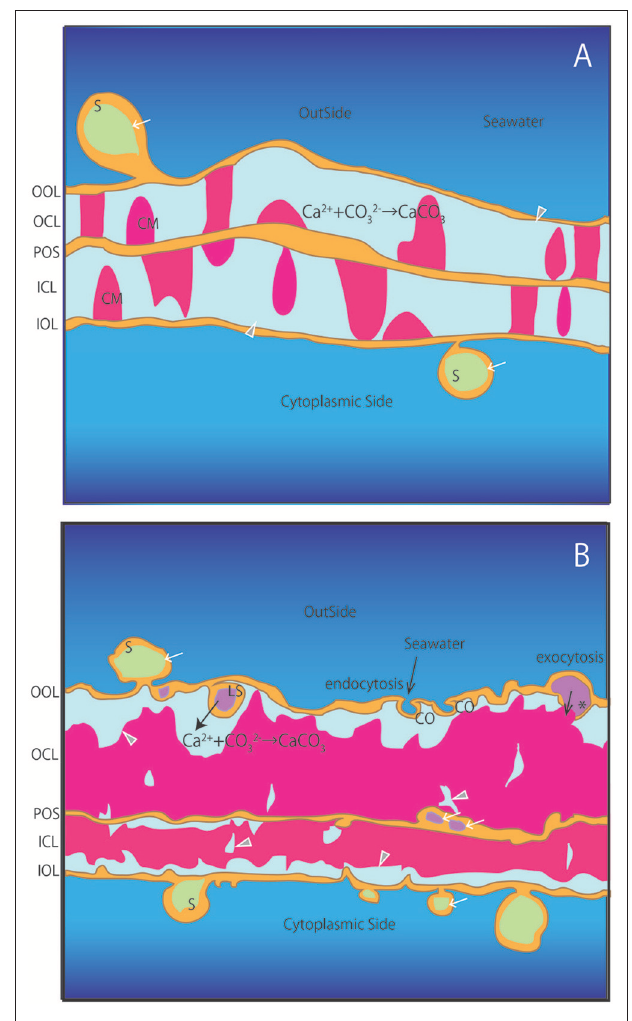
FIGURE 9 | Schematic illustration of the SOC. (A) Earlier stages corresponding to specimens #1 and #2. (B) Later stages corresponding to specimens #3-#5. OOL, outer organic layer; OCL, outer calcareous layer; POS, primary organic sheet; ICL, inner calcareous layer; IOL, inner organic layer; S, spherical structures; CM, calcareous materials; PP, pore plate; gray triangles, void; white arrows, cavities in the organic structure; CO, concavity; asterisk, opening spherical structure from cavity into void; LS, spherical structure with larger cavity inside projection to